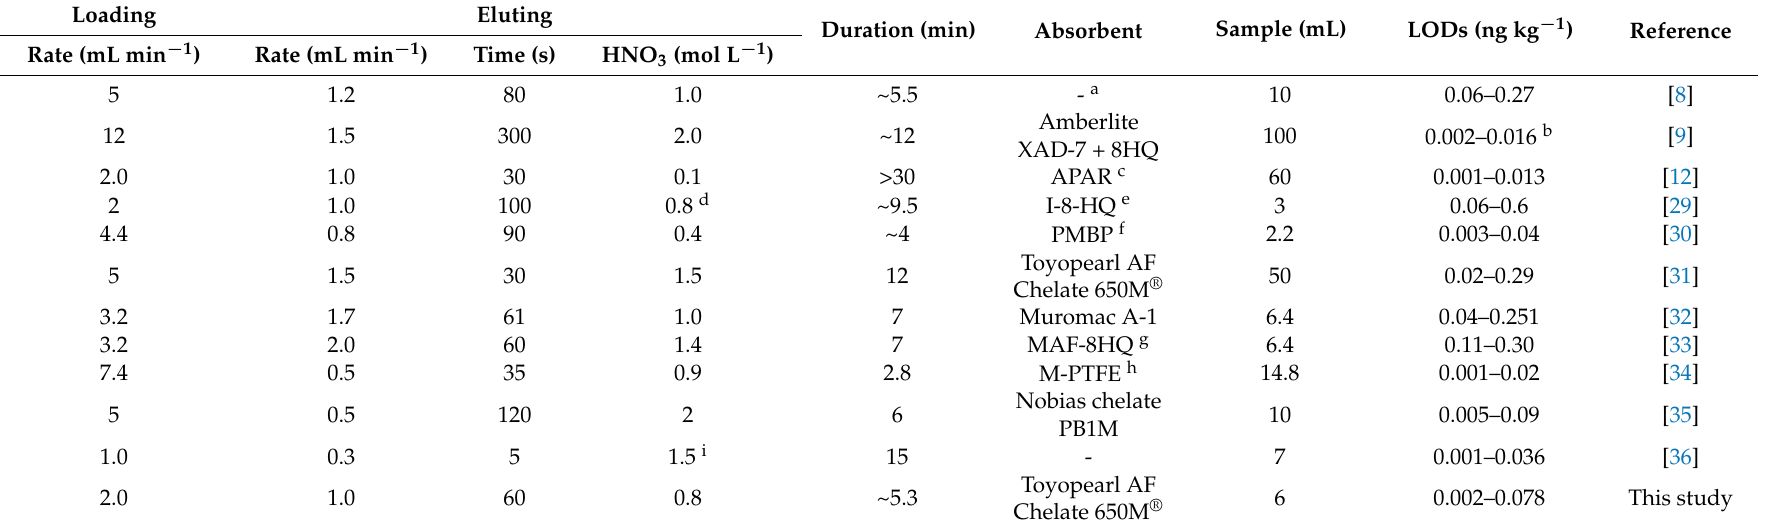
Table 3. Comparison with other FI-ICP-MS methodologies for the determination of YREEs in